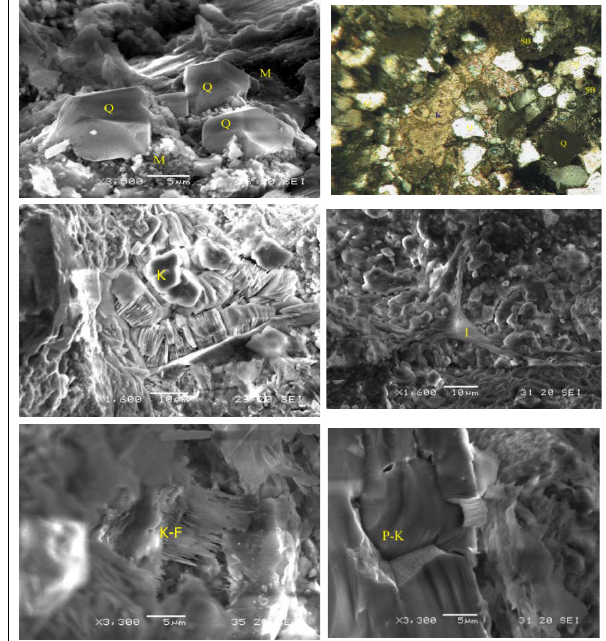
Figure 7: SEM showing cements of quartz(Q) overgrowth, authigenic kaolinite(K), authigenic illite (I) and feldspar (K-F and P-K) and calcite